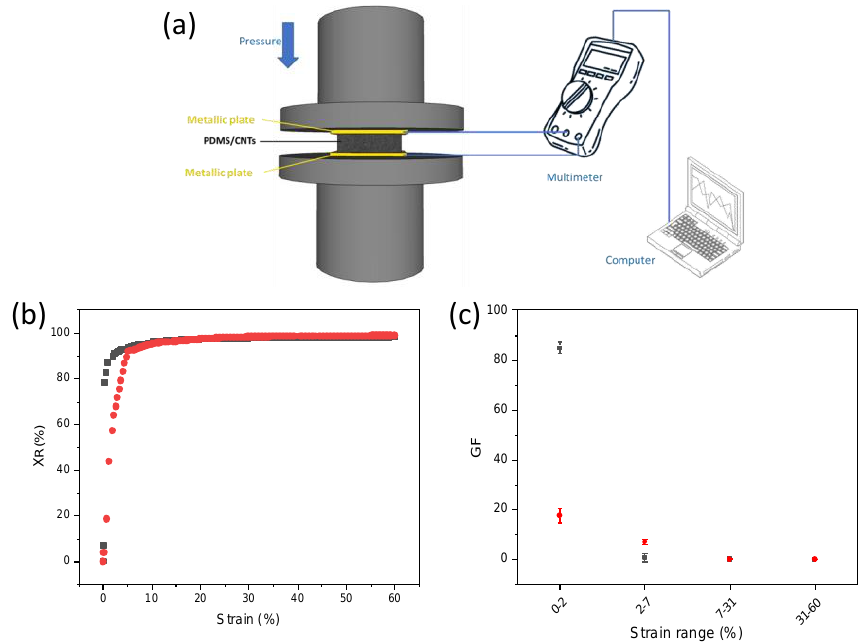
Figure 5. ( a ) Scheme of the set-up used for piezoresistive measurements, ( b ) relative resistance varia- tion at different strain in PDMS/CNTs long (gray curve), PDMS/CNTs short (red curve), ( c ) gauge factor variation at different strains range for PDMS/CNTs long (gray curve), PDMS/CNTs short (red